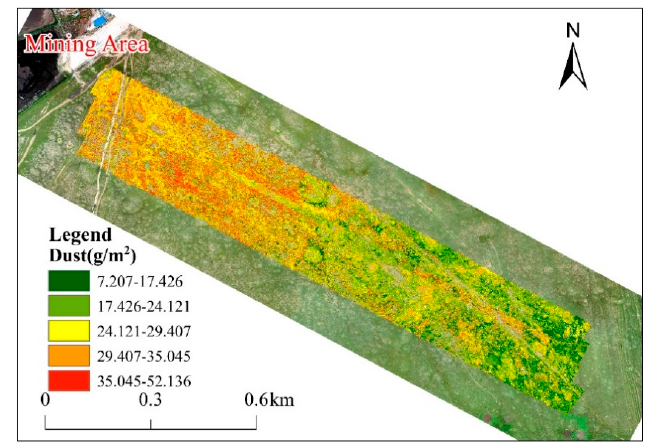
Figure 7. Spatial distribution map of canopy dust retention.